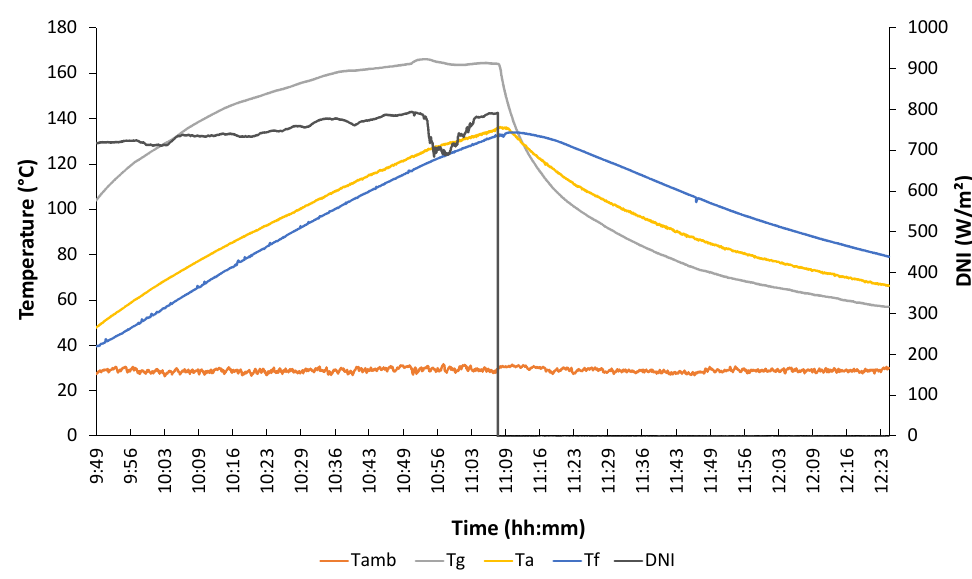
Figure 6. Results of a silicone oil test (17/06/2019, test